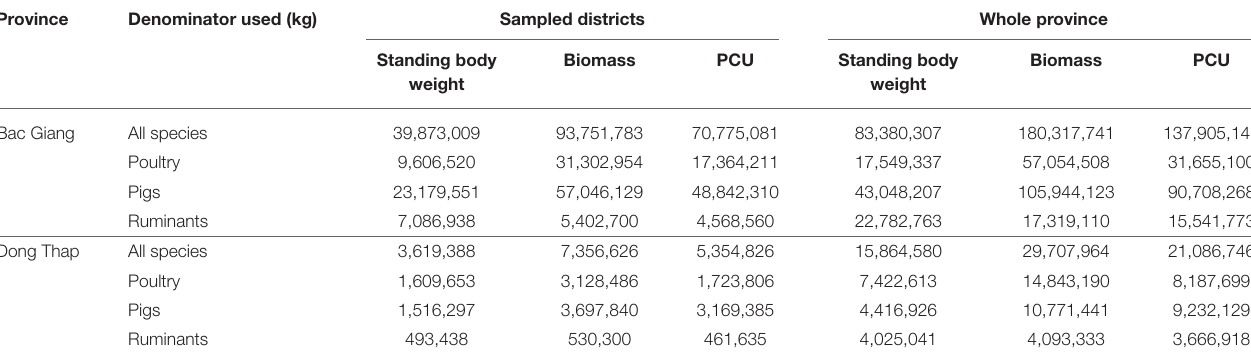
TABLE 3 | Animal population denominators used for AMU calculations in two pilot provinces (based on population estimates provided by SDAH in Dong Thap and Bac Giang in 2020). Province Denominator used (kg) Sampled districts Whole province Standing body Biomass PCU Standing body Biomass weight weight